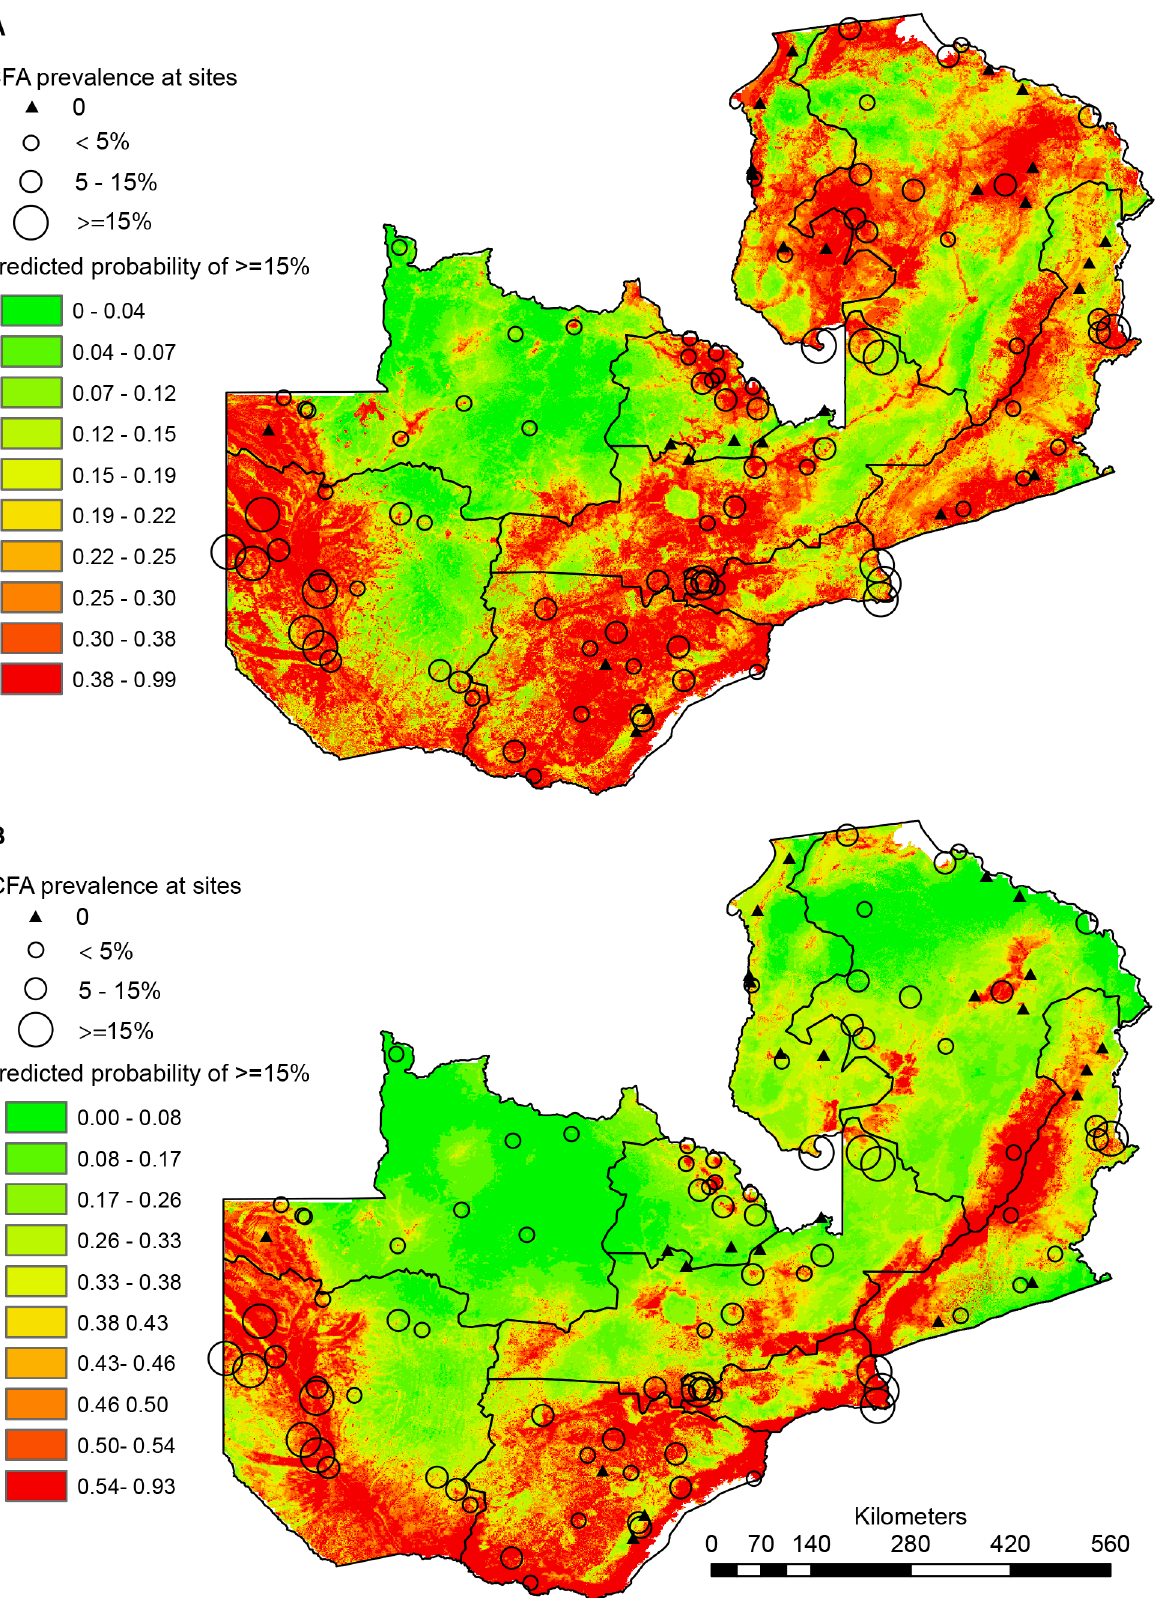
Figure 3. Maps of the MaxEnt predicted distributions of CFA prevalence categories. (A) The heatmap values represent the relative probabilities of presence of LF with at least 5%, CFA prevalence (model 1). (B) The heatmap represent the predicted relative probability of presence of LF with at least 15% CFA prevalence (model 2). doi:10.1371/journal.pntd.0002714.g003 PLOS Neglected Tropical Diseases |